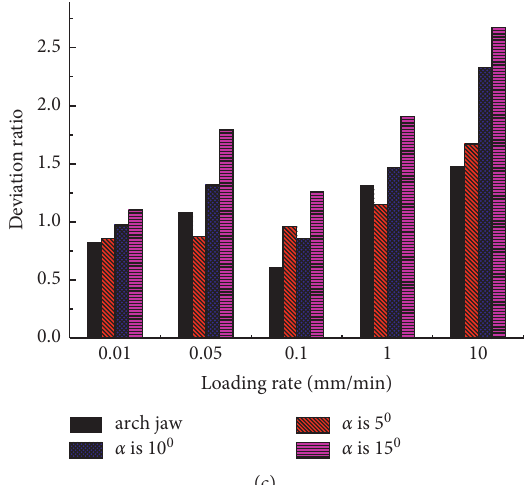
Figure 7: Deviation ratios for the increasing loading rates: (a–c) deviation ratios for the sandstone, rust stone, and granite stone specimens, respectively.